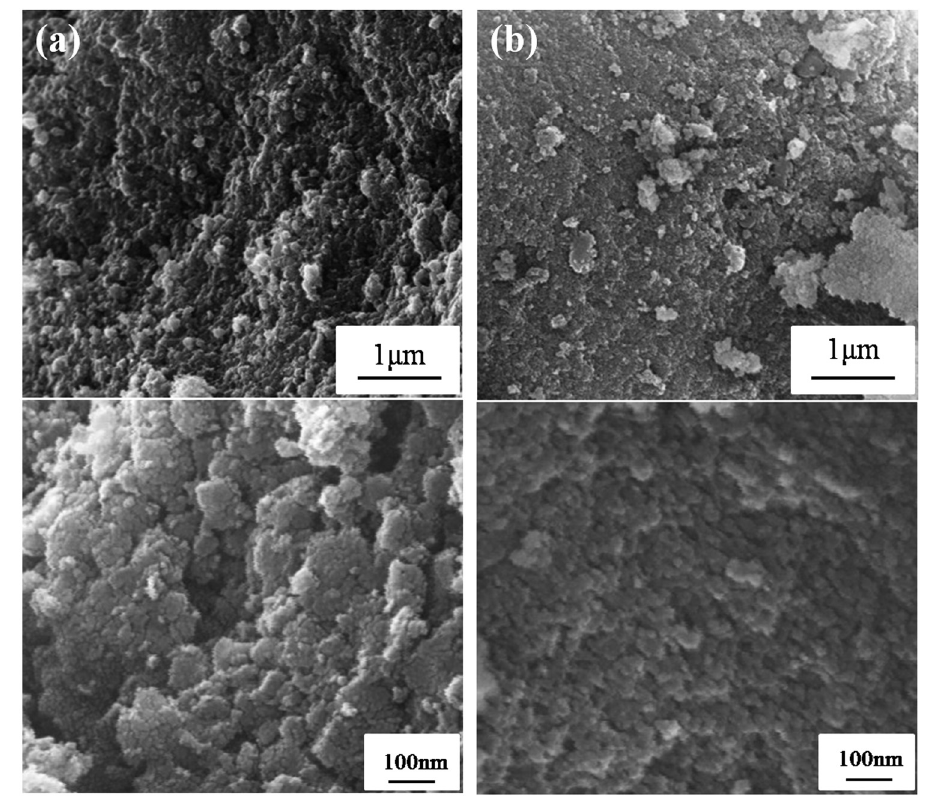
Figure 15: SEM micrographs of ceramics derived from ( a ) AHPCS and ( b ) PACS - 5 annealed at